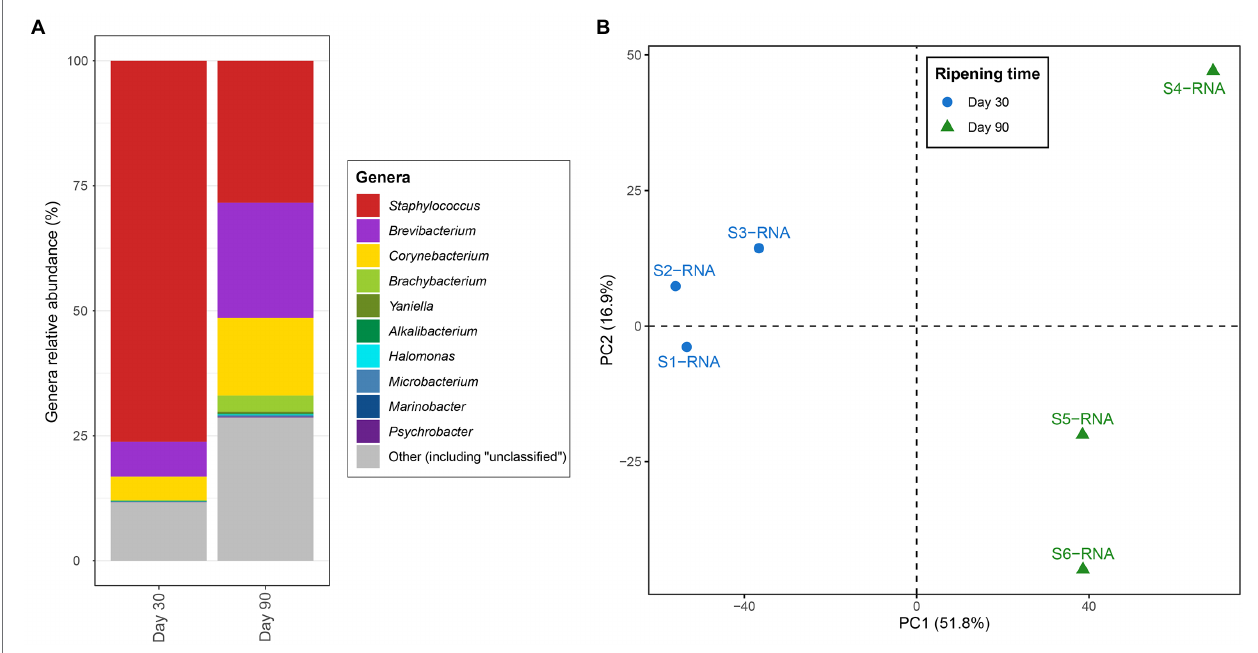
FIGURE 1 | (A) Percent of transcript aligned to the coding sequences assigned to the different genera identified in VB rinds. The “Other” section includes other genera as well as genomic regions where the genus-level resolution was not achieved. (B) Principal component analysis (PCA) based on the transcription values [calculated as transcripts per million (TPM)] assigned to the different Kyoto Encyclopedia of Genes and Genomes (KEGG) orthologues and